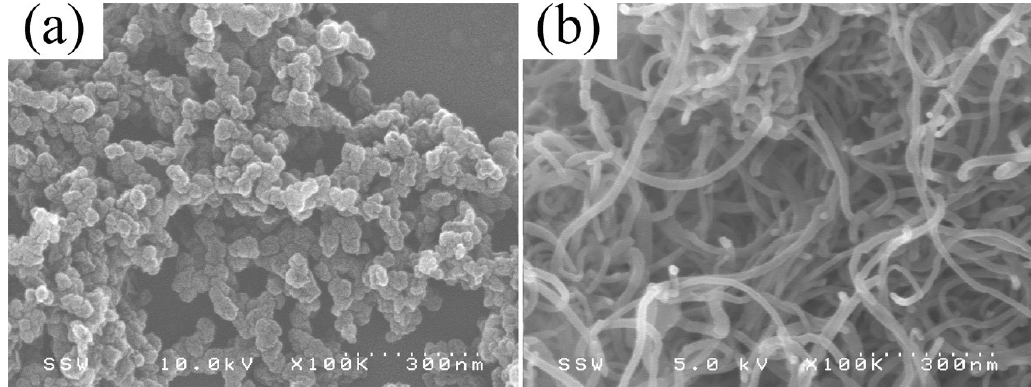
Figure 1. The morphology of ( a ) high structure carbon black and ( b ) multi-walled carbon nanotubes.